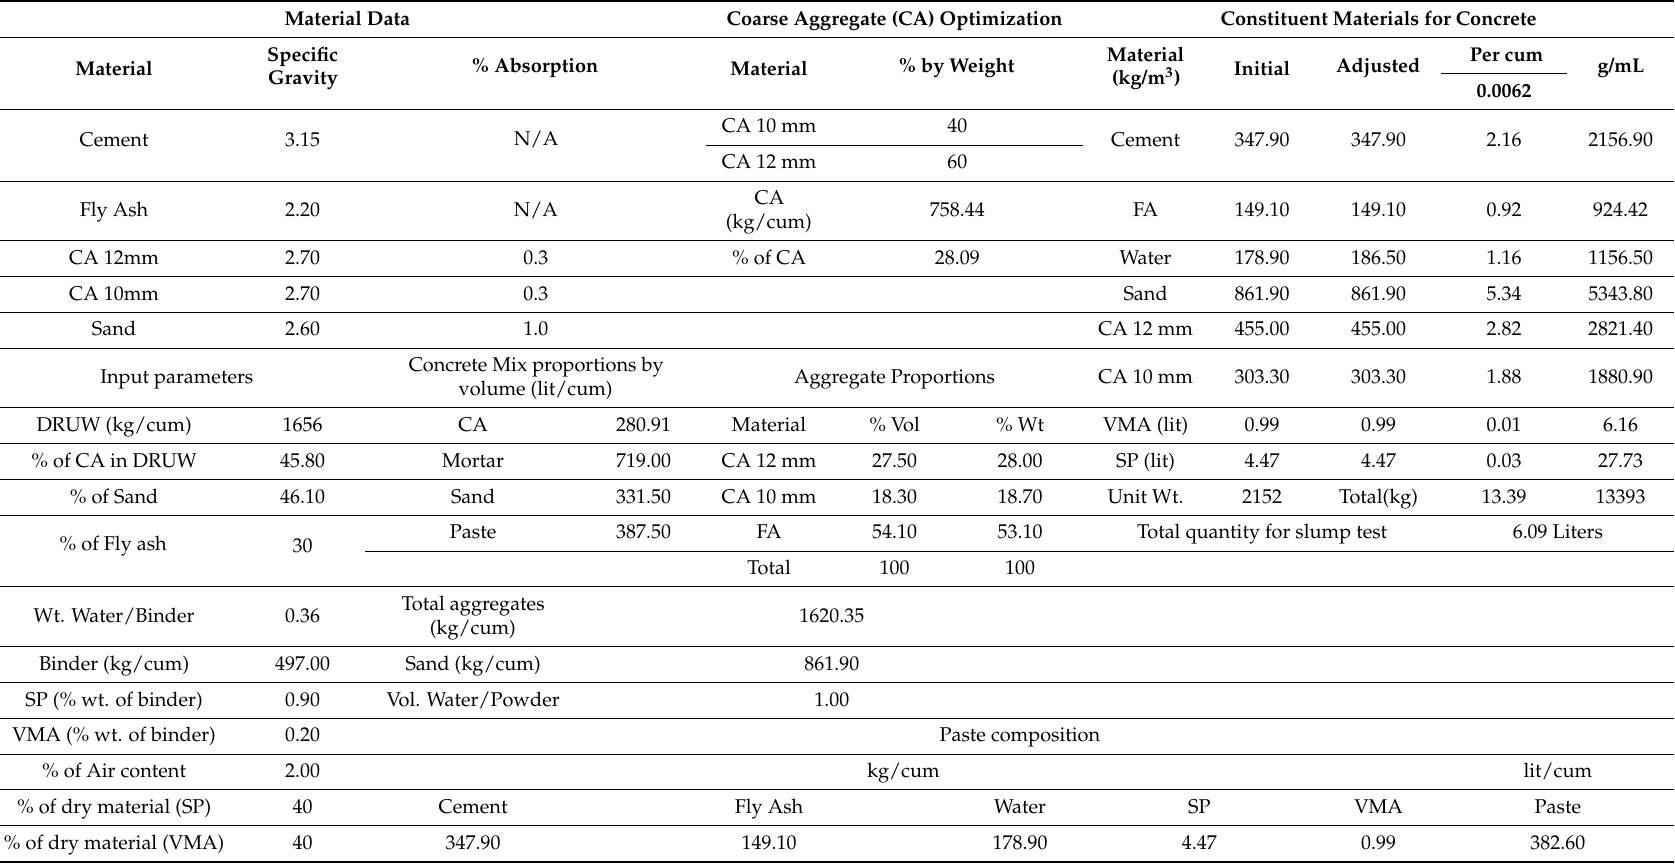
Table 1. Design of self-compacting concrete and optimization of constitute